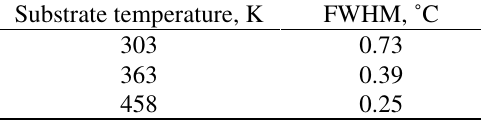
Table 2 . Variation of FWHM of preferential orientation with substrate temperatures for the CoPc thin